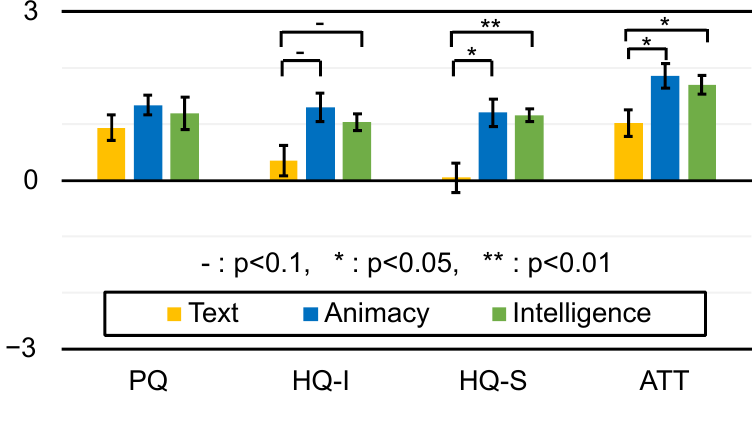
Figure 9. Results of AttrakDiff in each category.